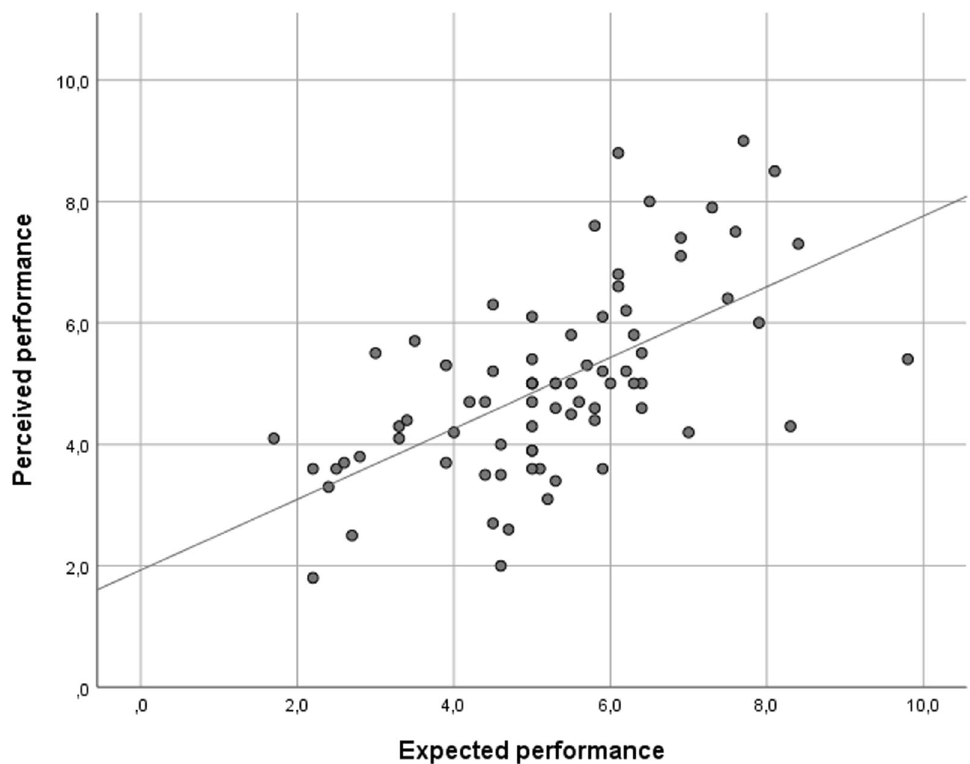
Fig. 7 The association between expected and perceived